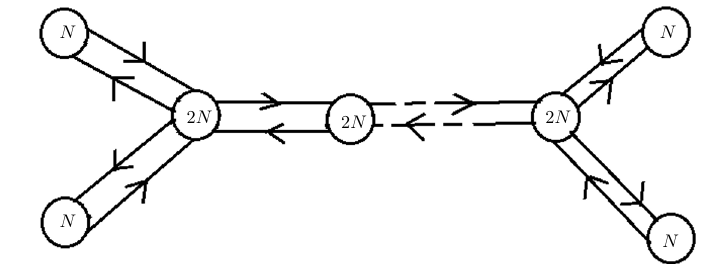
Figure 5 . b D n quiver diagram with gauge group U(2 N ) n (cid:0) 3 (cid:2) U( N ) 4